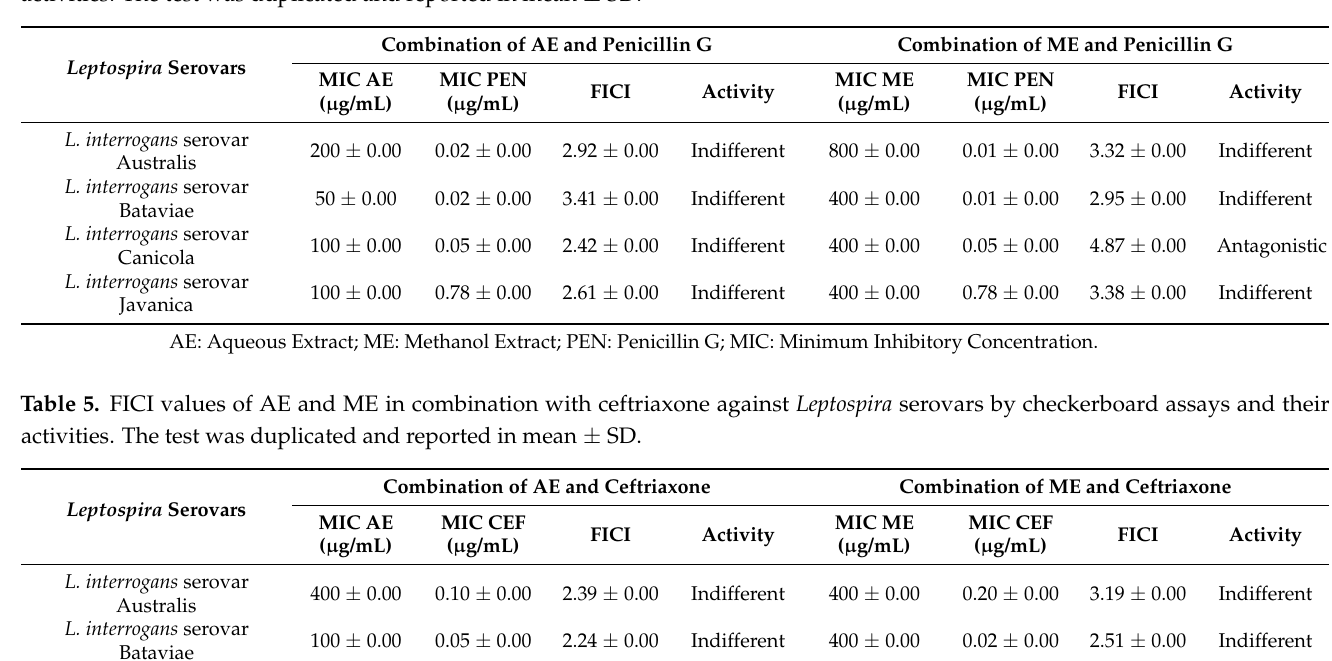
Table 4. FICI values of AE and ME in combination with penicillin G against Leptospira serovars by checkerboard assays and their activities. The test was duplicated and reported in mean ± SD.